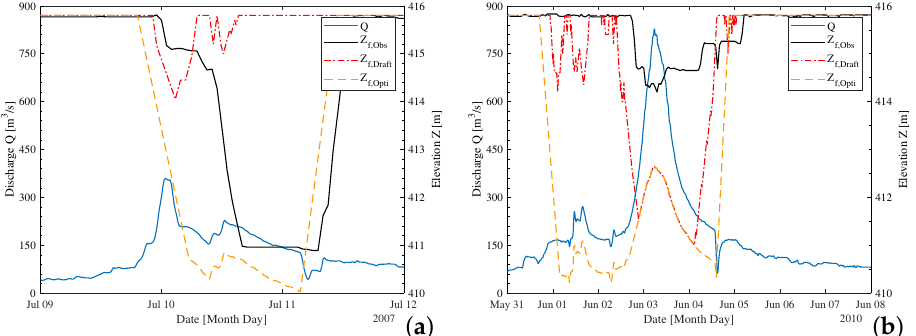
Figure 11. Hydrograph and corresponding water surface levels for sediment-flushing for the observed (black), the draft (red) and the optimised (orange) scheme for two time periods: ( a ) July 2007; and ( b ) June